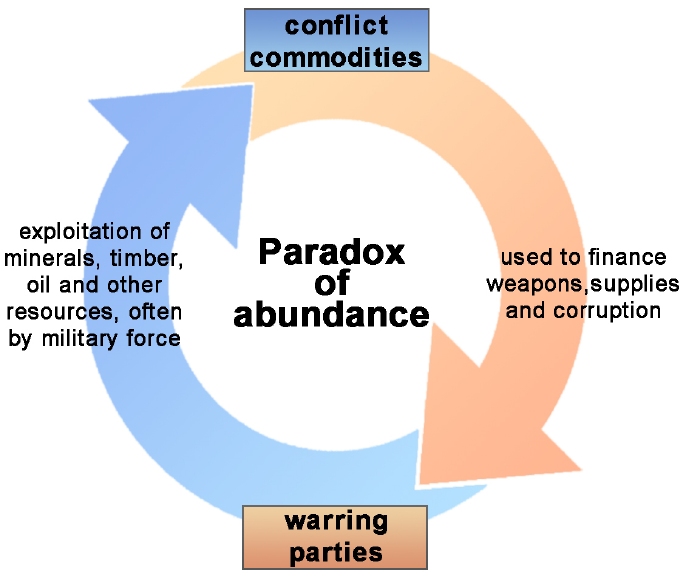
Figure 2. The paradox of abundance: How conflict commodities fuel warring parties and how the latter seek for revenues from the abundance of natural